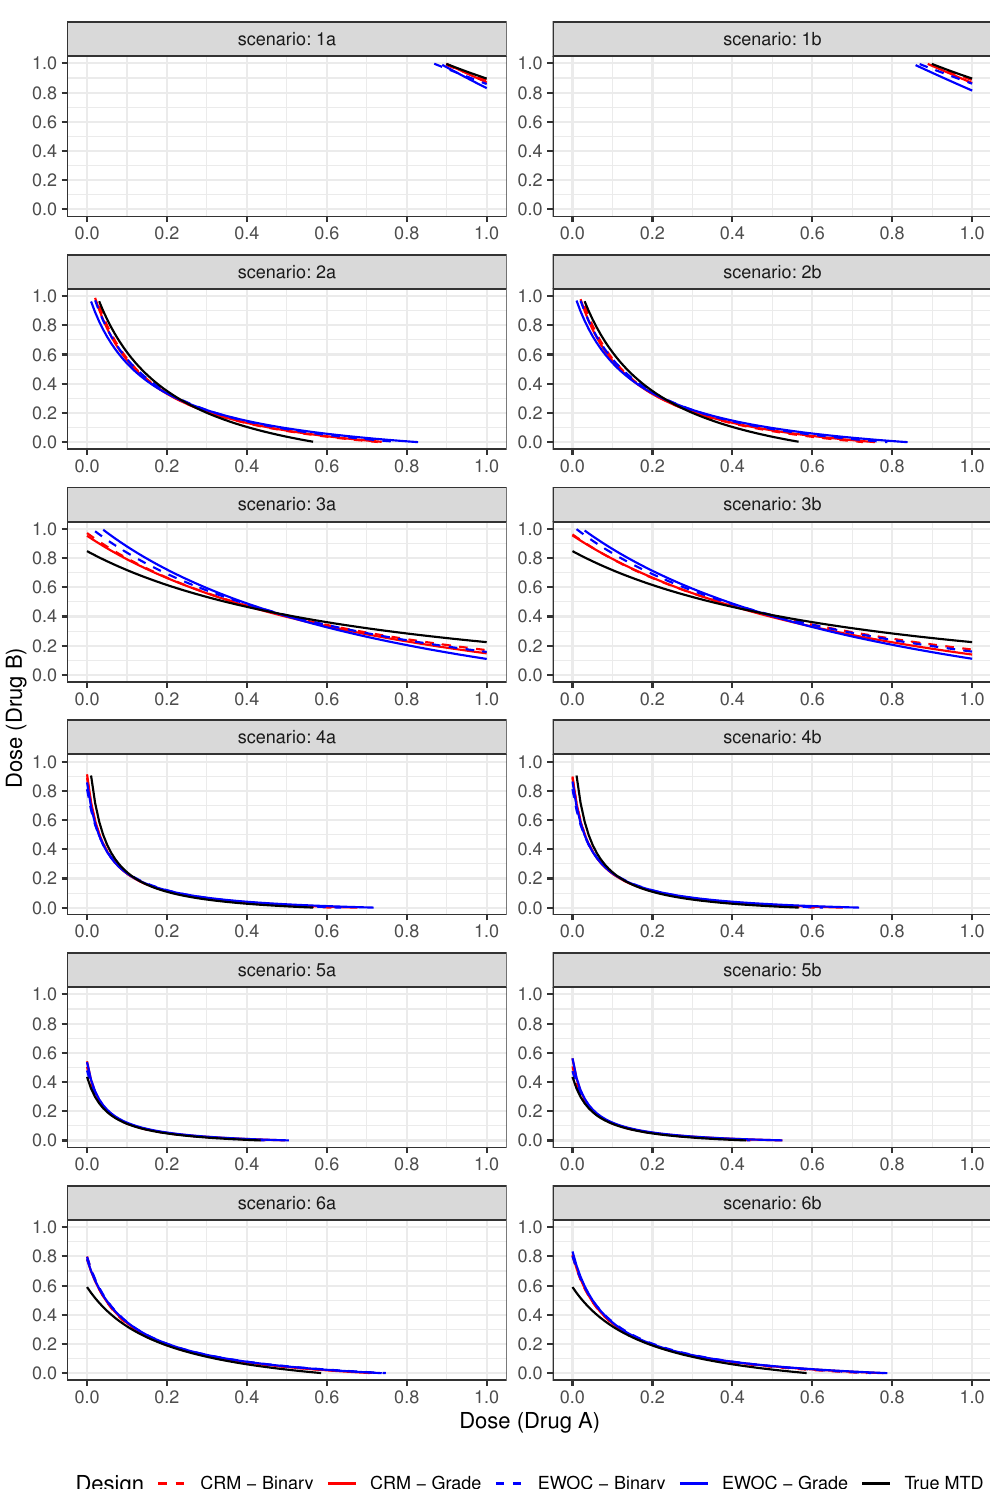
Figure 1. True and estimated MTD curves under Scenarios